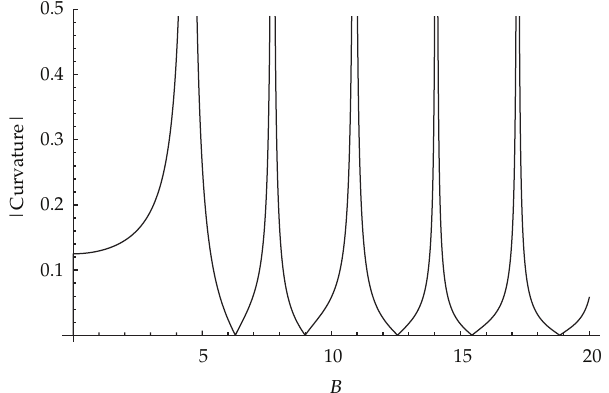
Figure 13: Graph of the magnitude of the curvature at the end x (cid:5) 0 plotted against B .